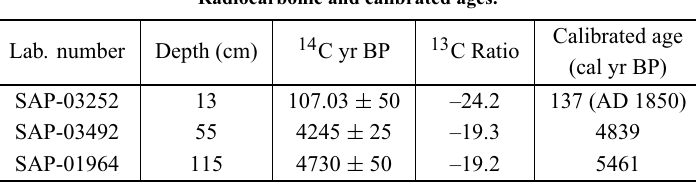
Radiocarbonic and calibrated